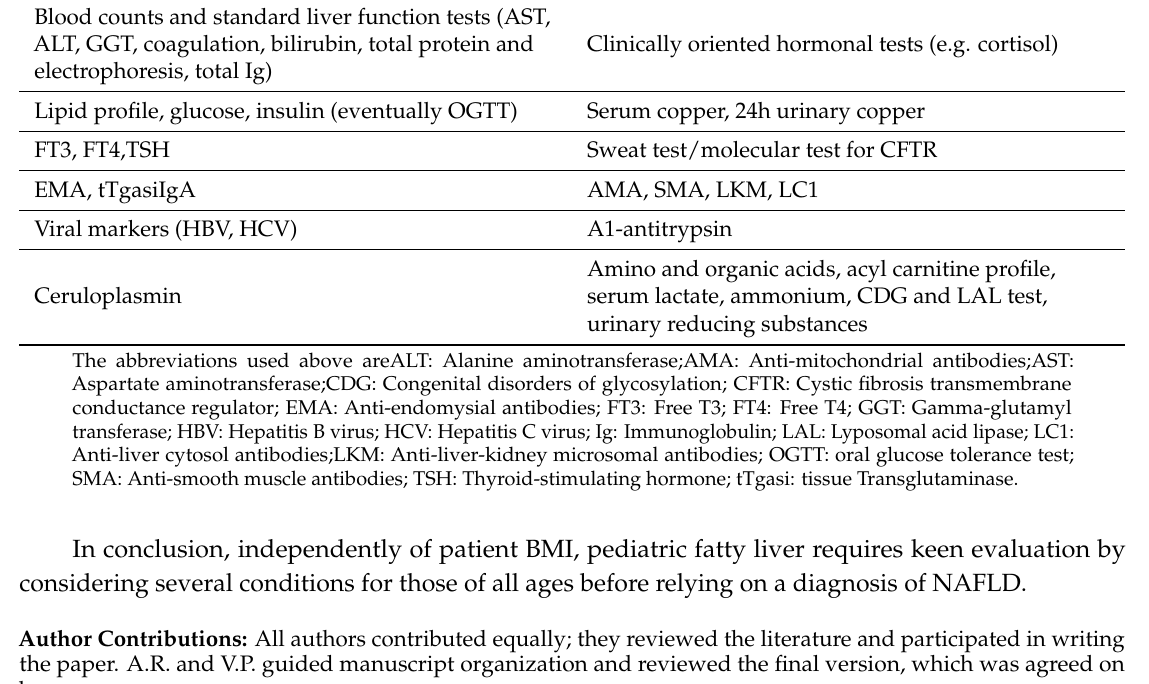
Table 2. Laboratory workup in children with fatty liver. 1st Step 2nd